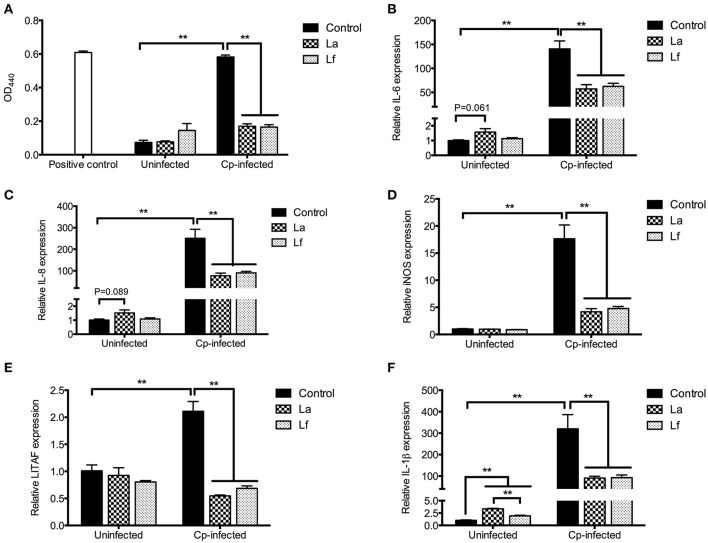
The cytotoxicity and cytokine mRNA expression in the C. perfringens-infected cells pretreated with lactobacilli. Cells were pre-incubated with L. acidophilus or L. fermentum (MOI = 1) for 2 h and then stimulated with C. perfringens (MOI = 0.1) for 6 h. Following infection, LDH released from cells to culture medium were detected (A). The mRNA expression of IL-6 (B), IL-8 (C), iNOS (D), LITAF (E) and IL-1β (F) were determined by qRT-PCR analysis. Data are presented as mean ± standard error (n = 3). **P < 0.01. La, L. acidophilus; Lf, L. fermentum; Cp, C. perfringens; IL, interleukin; iNOS, inducible nitric oxide synthase; LITAF, lipopolysaccharide induced TNF factor.